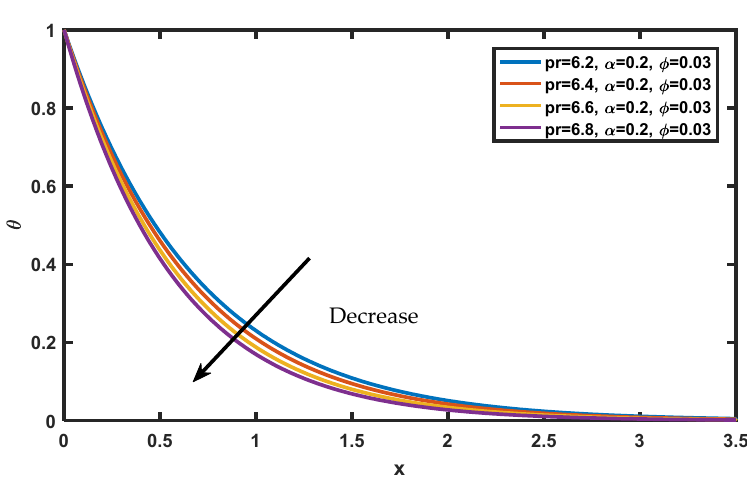
Figure 7. Variation of φ in θ .